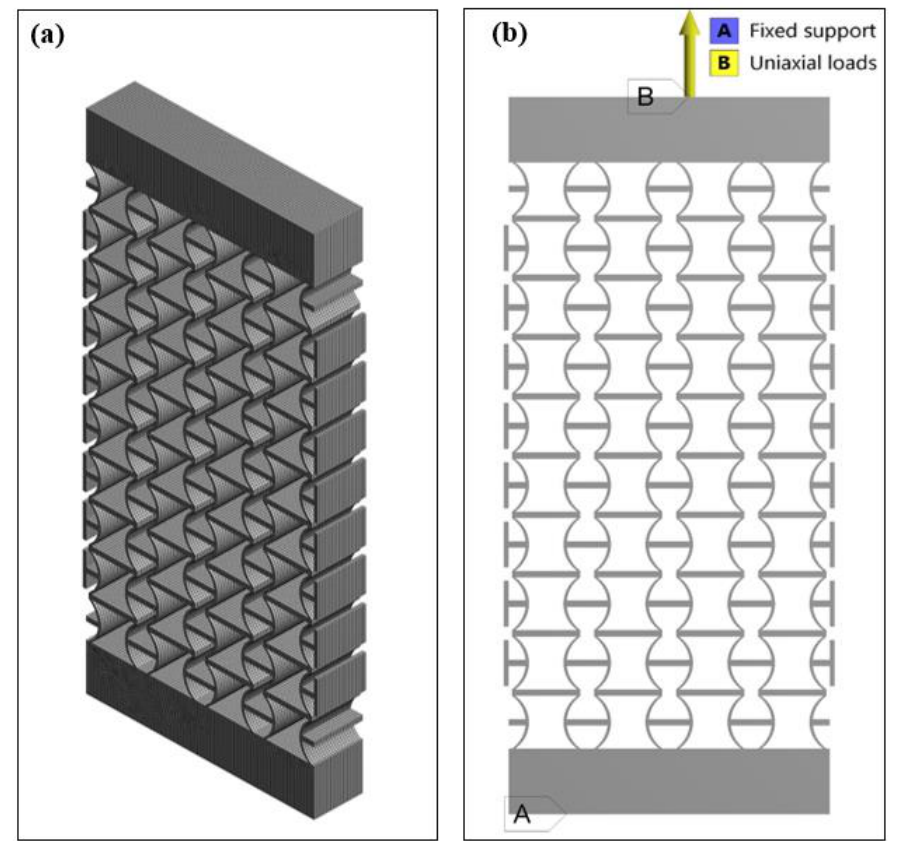
Figure 3. ( a ) Element division and ( b ) boundary conditions in the structure simulation.